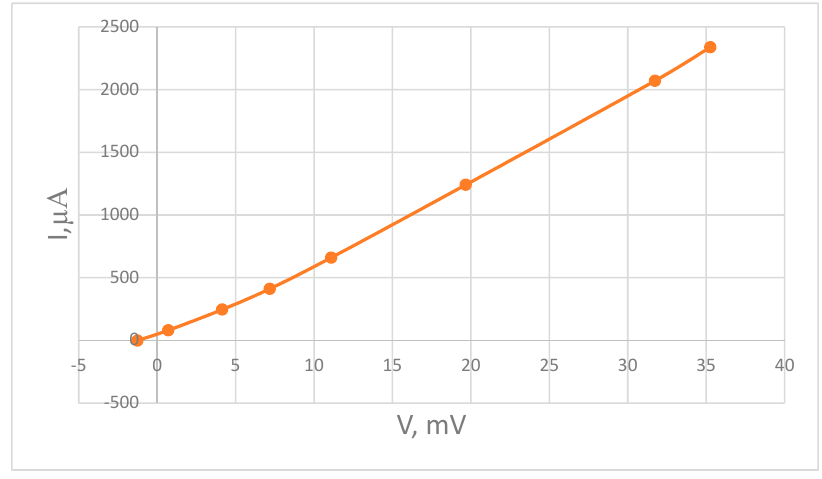
Figure 7. I-V characteristics of the MHD cells.